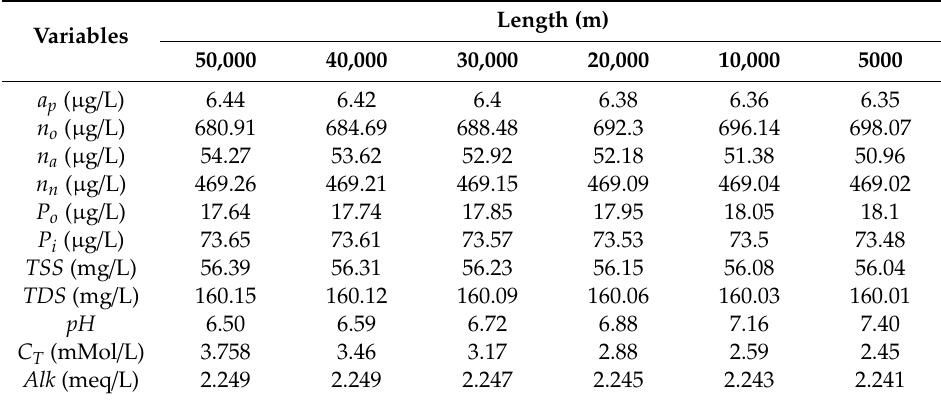
Table 13. E ff ect of channel length on the water quality